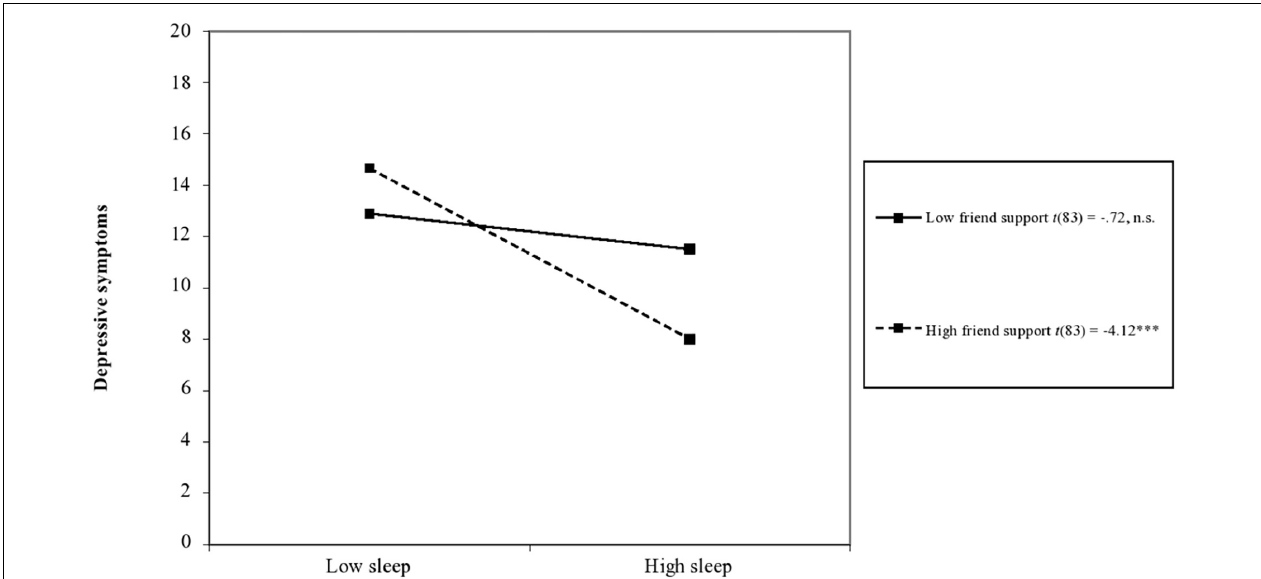
FIGURE 1 | Interaction between sleep duration/quality and social support from friends predicting adolescent parents’ depressive symptoms. Notes: t -values are unstandardized simple slopes. n.s. , not significant, ***p <